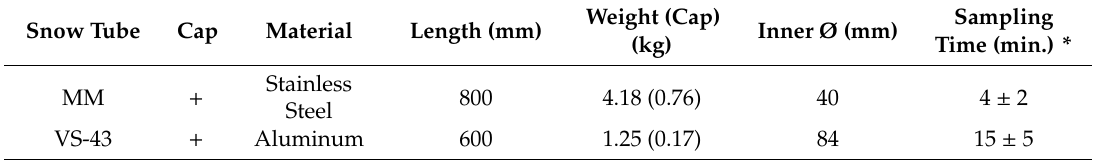
Table 2. Main characteristics of the snow tubes used in this